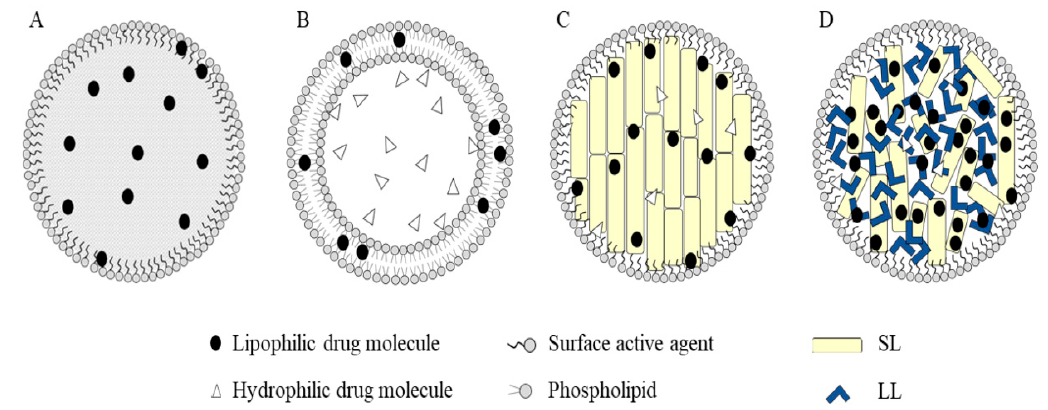
Figure 2. Di ff erent types of lipid-based nanoparticles: ( A ) nanoemulsions; ( B ) liposomes; ( C ) solid lipid nanoparticles (SLNs); ( D ) nanostructured lipid carriers (NLCs). Adapted from Haider et al. [67].